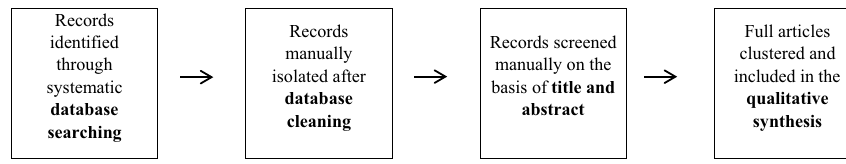
Fig. 2 Phases of the systematic literature search and qualitative